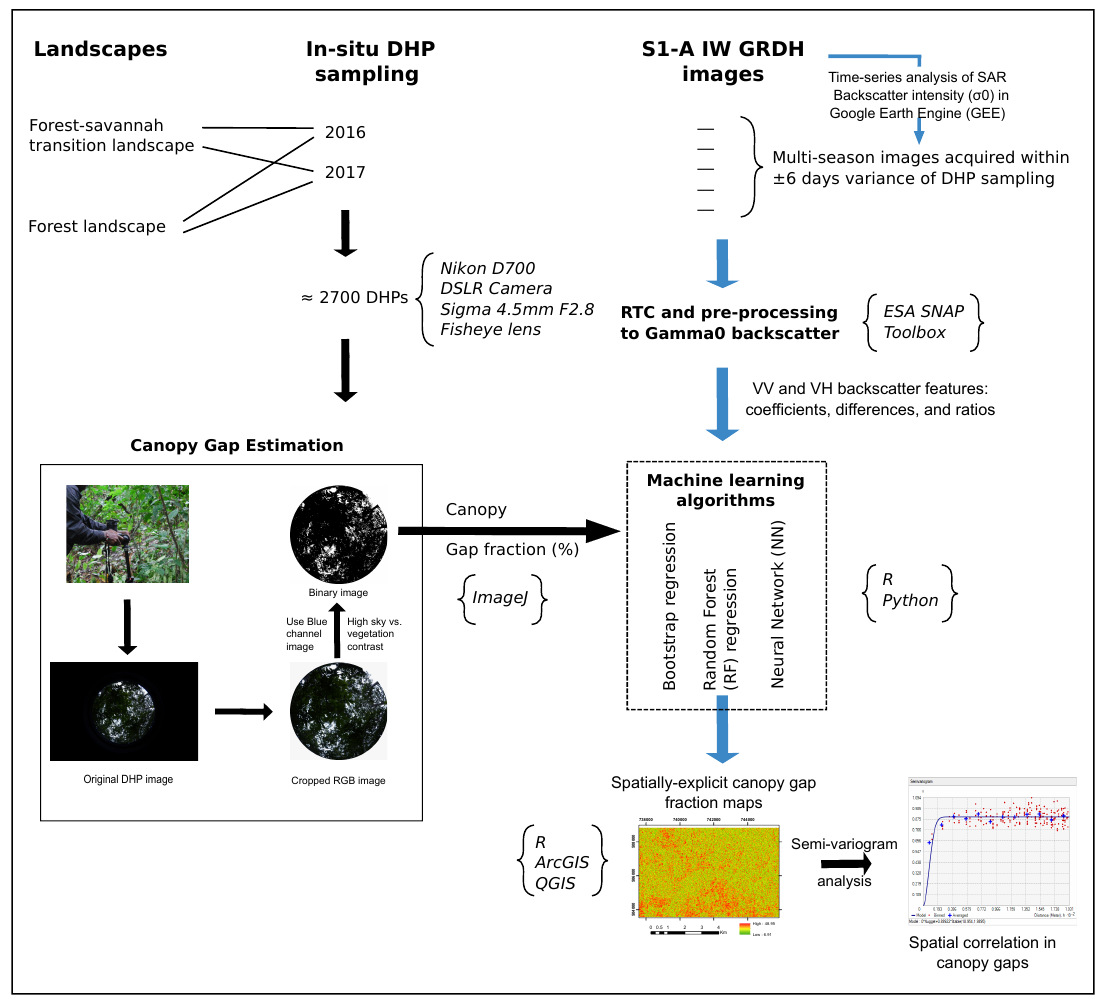
Figure 5. Framework for the used methods and estimation of canopy gap distribution. The tools or software, used at each analysis step, are indicated within braces. The black arrows = all acquired information from preceding steps in the analysis; the blue arrows = informed selection of data or algorithm from available